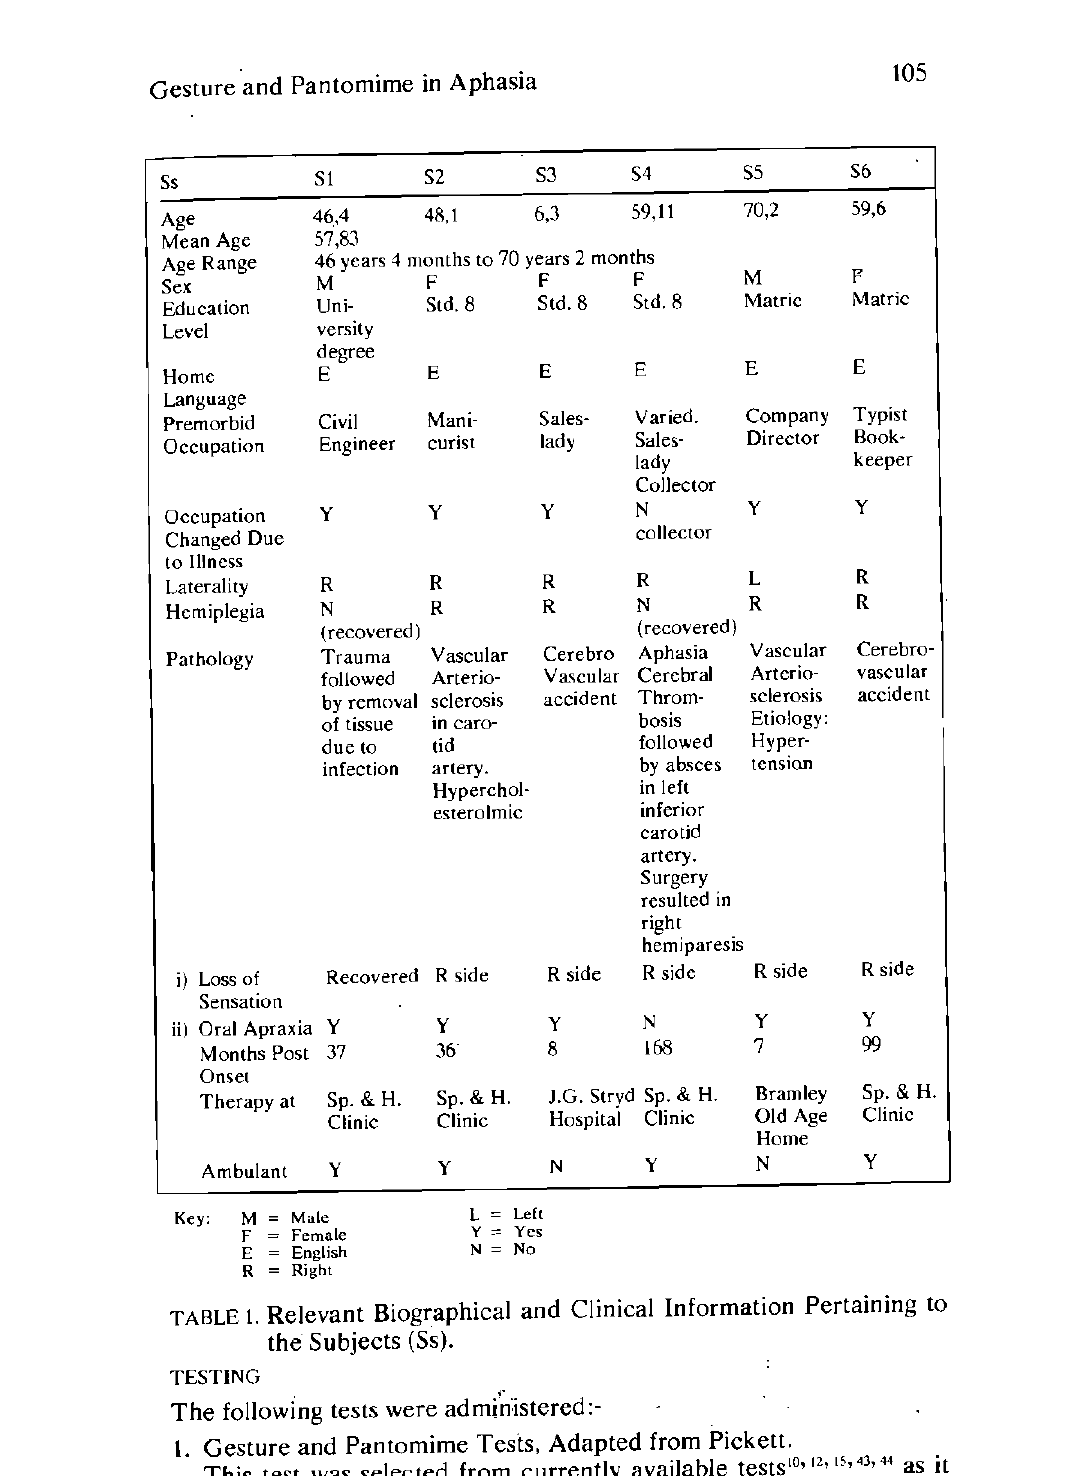
TABLE l. Relevant Biographical and Clinical Information Pertaining to the Subjects